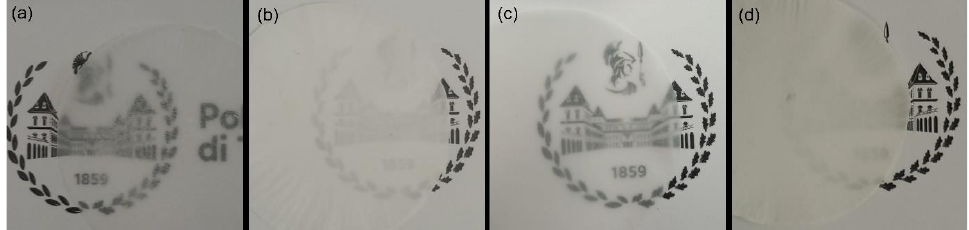
Figure 2. Photos of composites: ( a ) PEGDA-MFC-L, ( b ) PEGDA-MFC-H, ( c ) SOEA-MFC-L, and ( d ) SOEA-MFC-H. ( d )